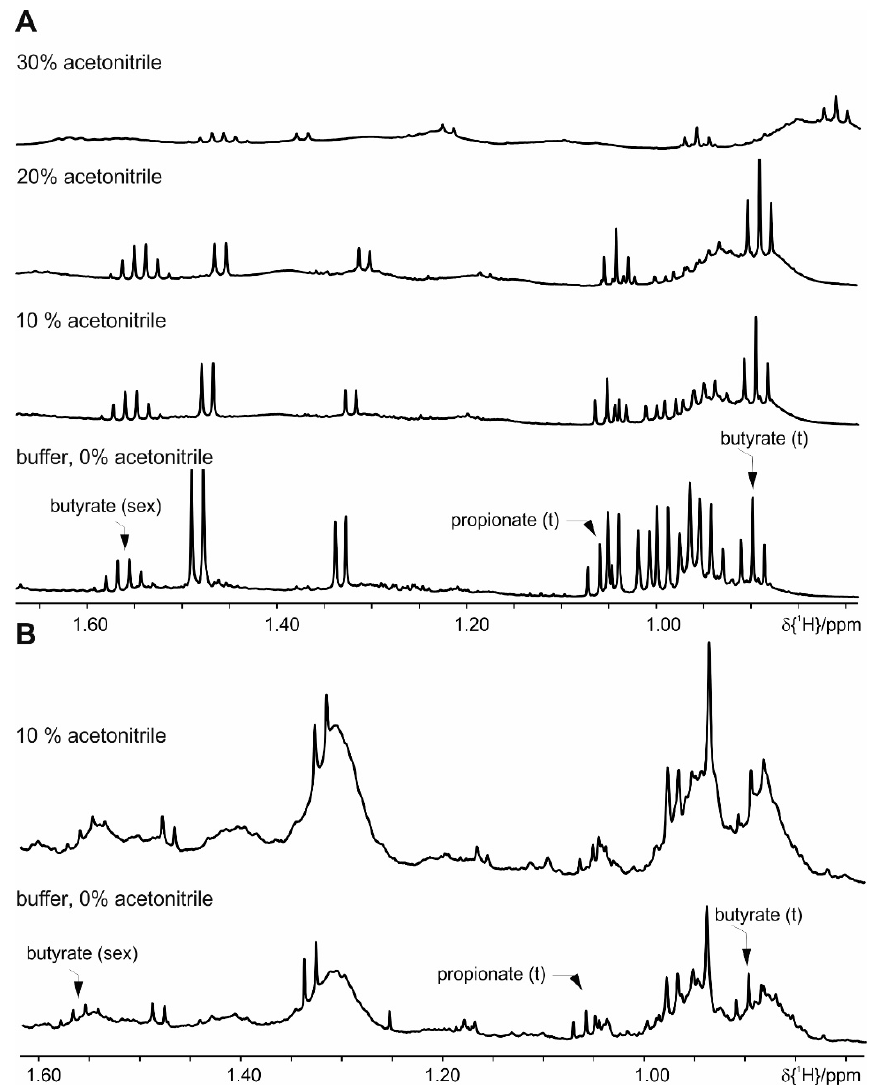
Figure 4. Effect of extraction with different concentrations of acetonitrile on the metabolite signals: ( A ) feces of mice fed on a standard diet and ( B ) on a HFD diet. For clarity only a selected spectral range of the proton NMR spectra is shown. Please note that the increased amount of acetonitrile induces chemical shifts on the signal resonances.